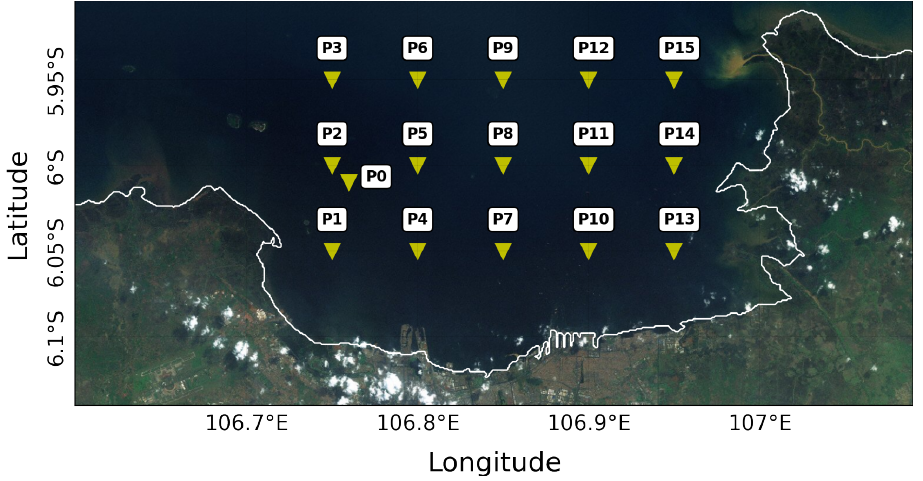
Figure 17. Locations of wave predictions in Jakarta